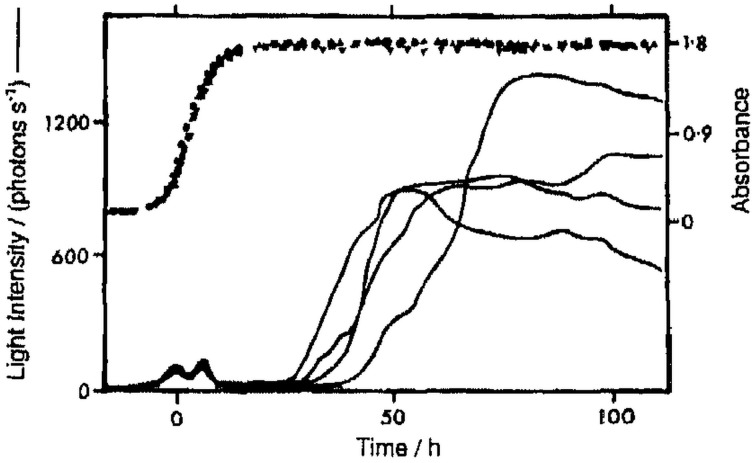
Growth and UPE curves of oxygenated suspension cultures of C. utilis at 33°C. Time given relative to the point of half-maximum growth (from Tilbury and Quickenden, 1992). Two distinctly different phases of UPE are present: (1) UPE from exponential phase cultures (two small peaks around 0 h) and (2) UPE of post-diauxic or stationary phase cultures 40–110 h).